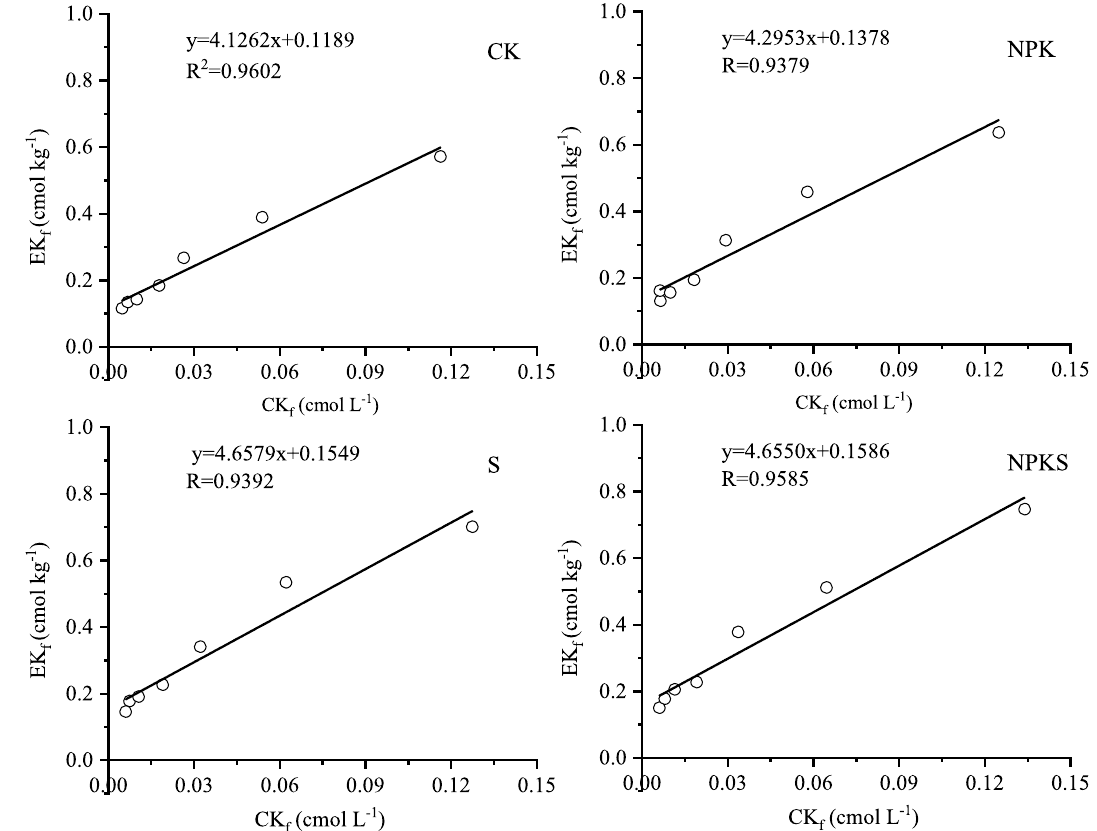
Figure 8. Plots of EK f versus CK f for tested soils with and without straw return. (CK, no fertilization; NPK, mineral fertilizing; S, straw 6000 kg h m −2 ; NPKS, NPK with straw 6000 kg h m −2 ; EK f , NH 4 OAc extractable K determined after equilibration period; CK f , Potassium concentration in soil solution after equilibration